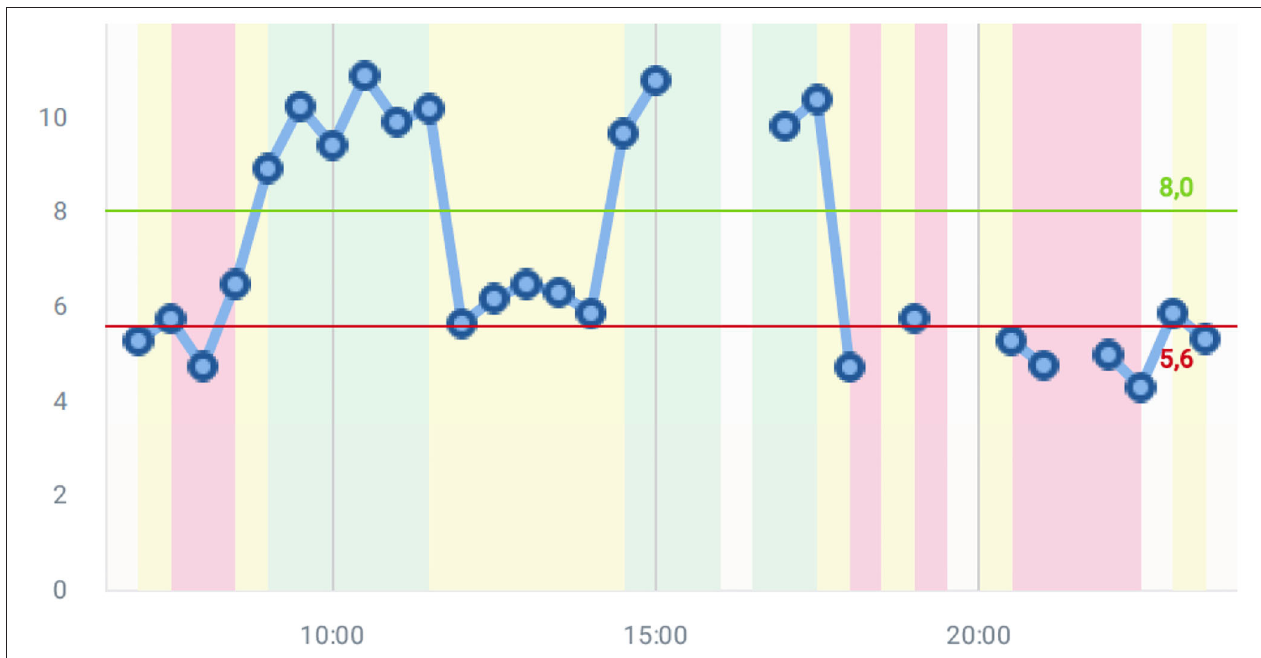
FIGURE 7 | A stride fluidity example.